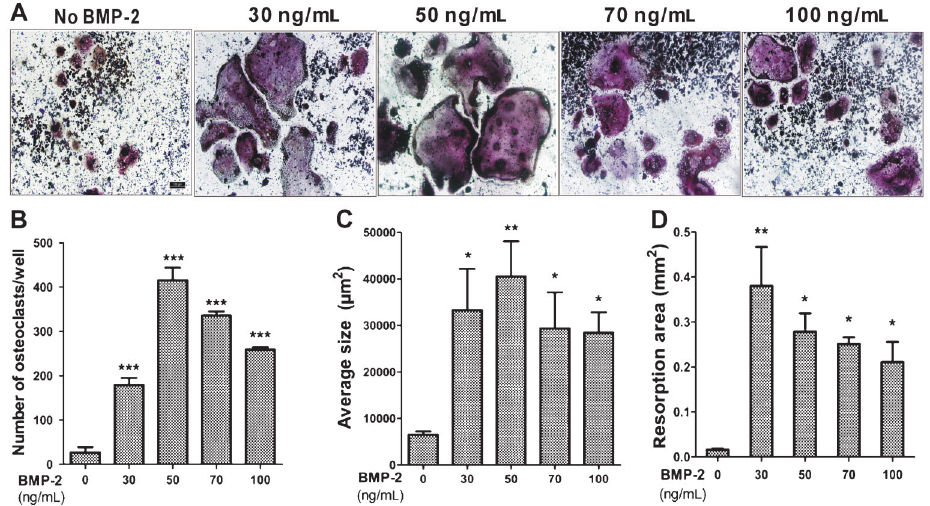
Figure 5. TRAP staining of RAW 264.7 cells-derived osteoclast formation. A , RAW 264.7 cells were treated with 30 ng/mL RANKL and 150 m g/mL titanium particles for 1 h, then treated with BMP-2 for 7 days. Quantitative analysis showing the number of osteoclasts per well ( B ), the average size of the 10 largest osteoclasts in each well ( C ) and the pit resorption area per well ( D ). Data are reported as means±SD. *P , 0.05; **P , 0.01 ***P , 0.001 (one-way